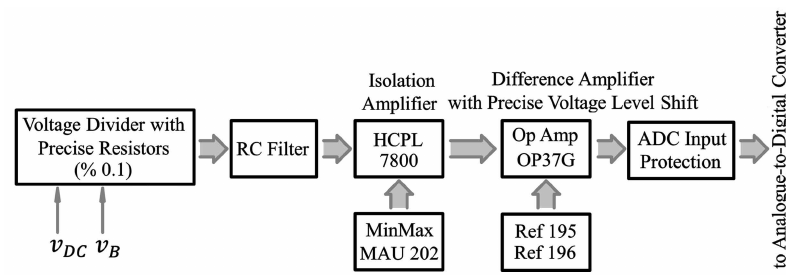
Figure 9. A common circuit to measure voltage in a